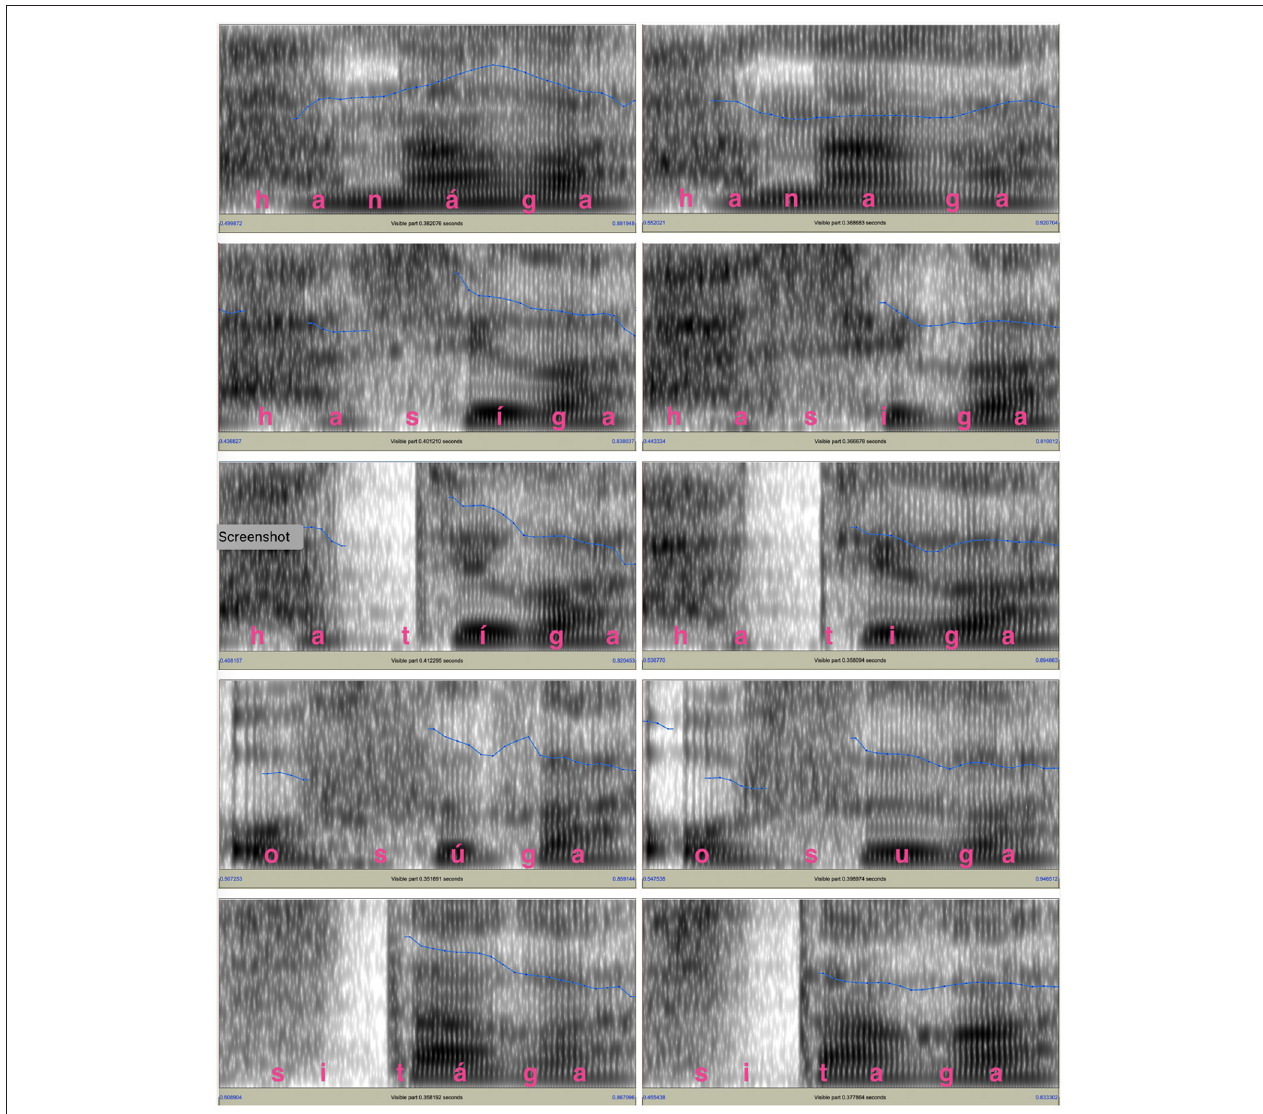
FIGURE 2 | The f o contours of the test words and the following particle for the female voice. The blue lines shown in the spectrograms indicate the f o movements. The f o range is between 75 Hz and 300 Hz for the f o s and 0 to 5,000 Hz for the